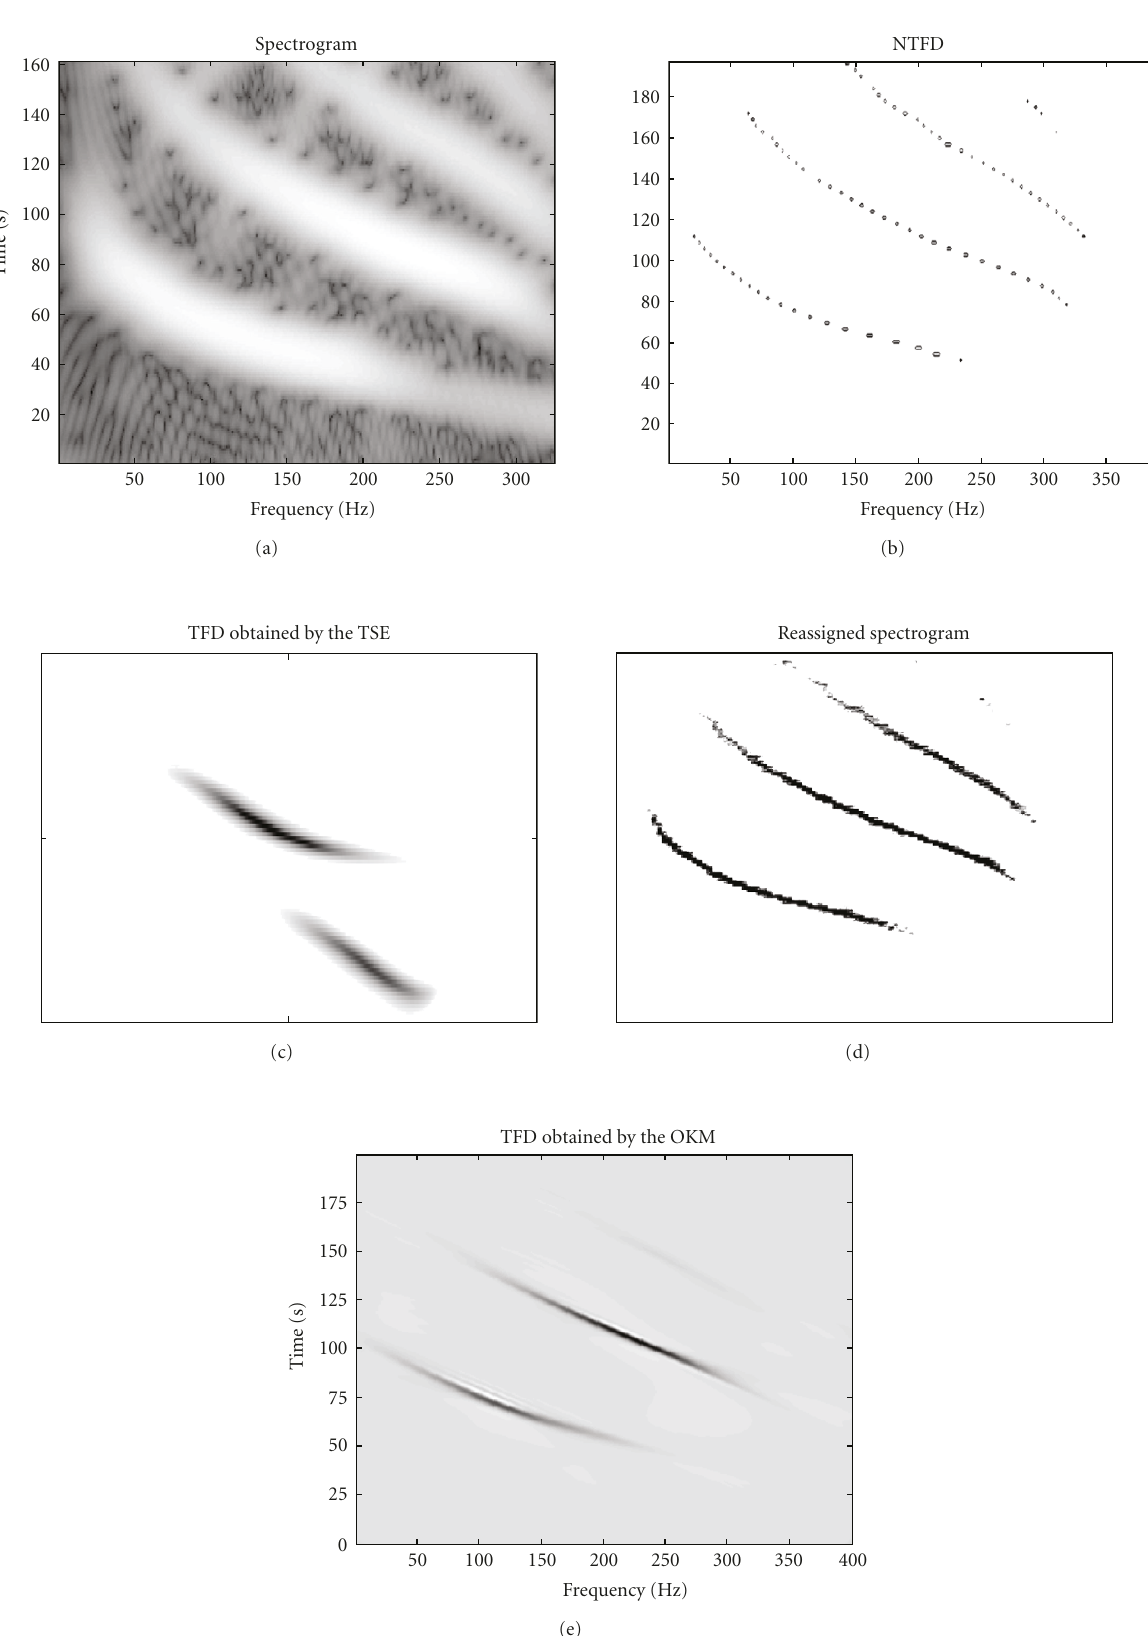
Figure 1: TFDs of the multicomponent bat echolocation chirp signal by various high resolution t-f